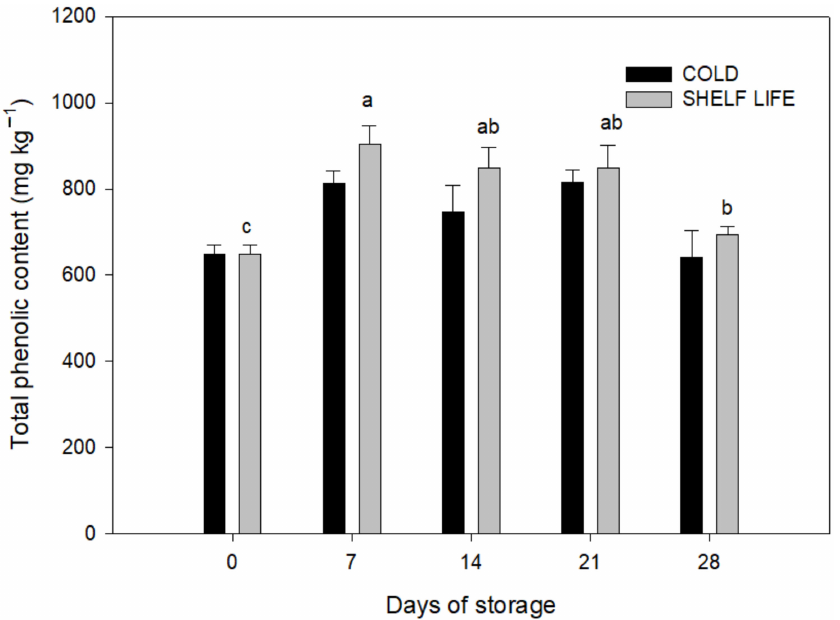
Figure 3. Total phenolic content changes in cactus pear fruit during cold and shelf life storage. Data are the mean ± SE ( n = 6). Tukey’s test at a 95% confidence level is shown. Different letters indicate significant differences ( p < 0.05) during each storage time.